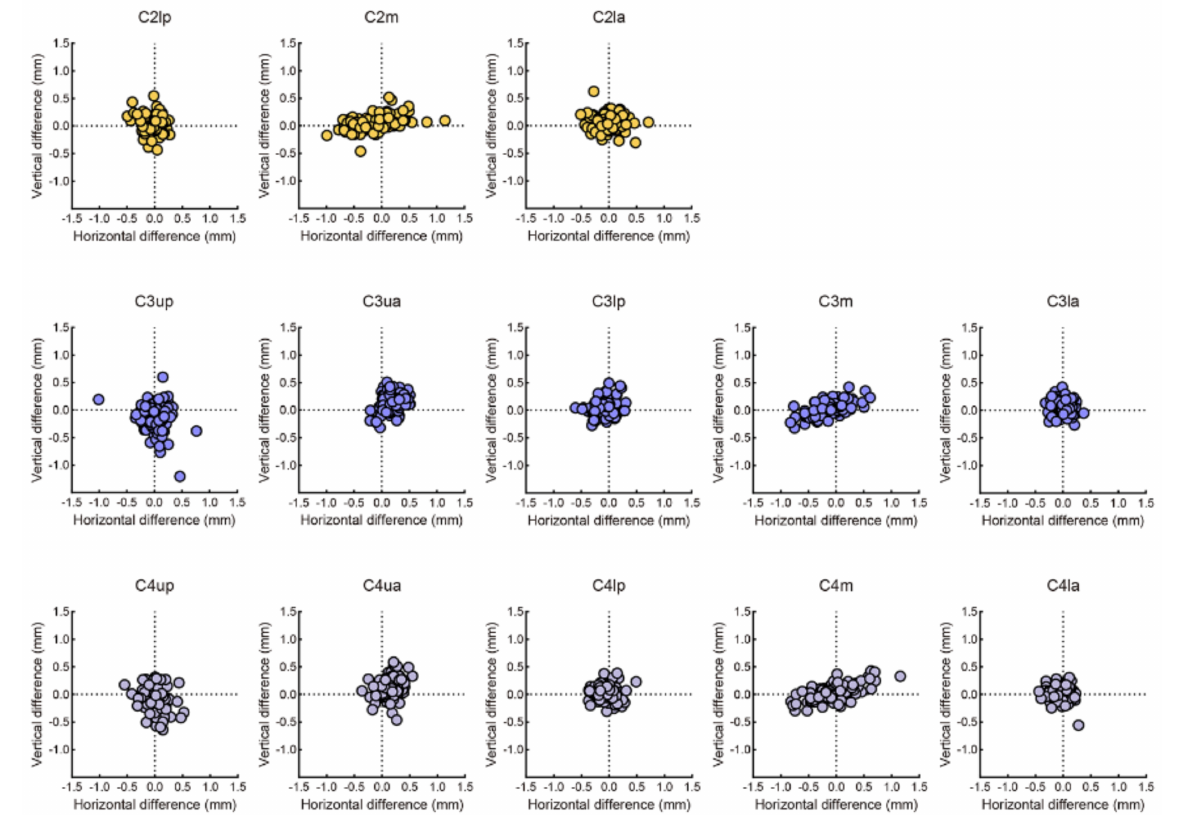
Figure 5. Scattergram representation of the labelling difference between AI and human. The mean differences between AI and human of C2 landmarks (line 1) were 0.29 ± 0.25 mm, 0.47 ± 0.33 mm, 0.35 ± 0.27 mm, respectively. The mean differences between AI and human of C3 landmarks (line 2) were 0.48 ± 0.38 mm, 0.42 ± 0.24 mm, 0.24 ± 0.15 mm, 0.37 ± 0.28 mm, 0.24 ± 0.17 mm, respectively. The mean differences between AI and human of C4 landmarks (line 3) were 0.42 ± 0.36 mm, 0.43 ± 0.27 mm, 0.25 ± 0.21 mm, 0.46 ± 0.27 mm, 0.27 ±± 0.18 mm, respectively. Table 3. Landmarks and measurements used to determine cervical vertebral morphology.